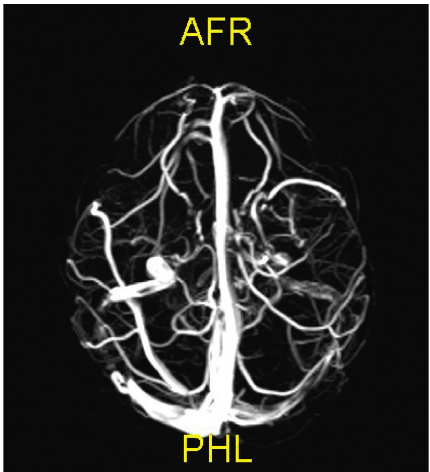
Figure 2: Hyperintense acute stage thrombus in the right transverse sinus and sigmoid sinus.